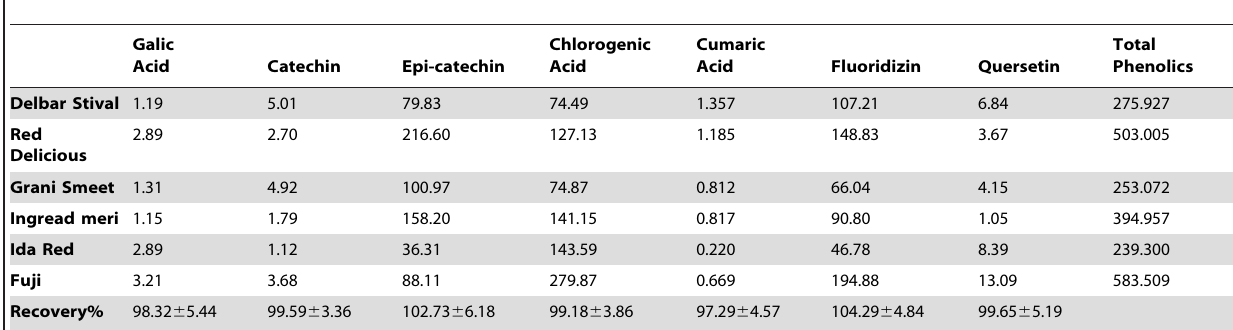
Table 2. The phenolic compound profile and total content in various variety of apple fruit in optimum extraction conditions.